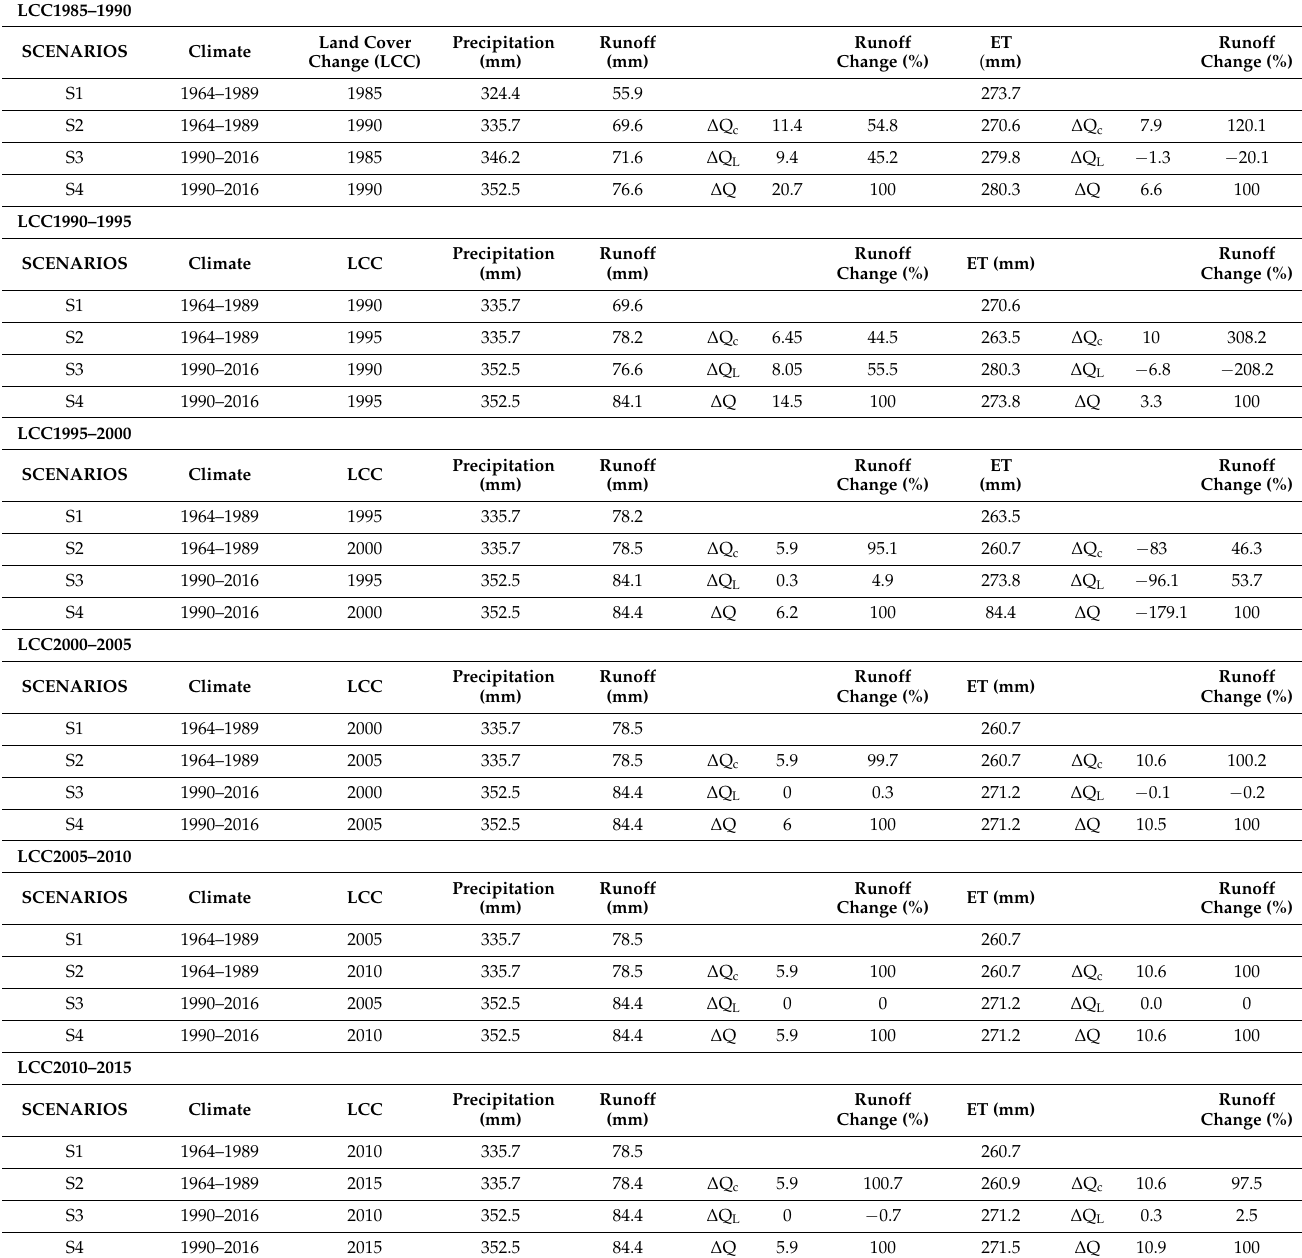
Table 5. Quantification of attribution of streamflow changes due to climate change and land-cover change for all scenarios using 1985, 1990, 1995, 2000, 2005, 2010 and 2015 land-cover data